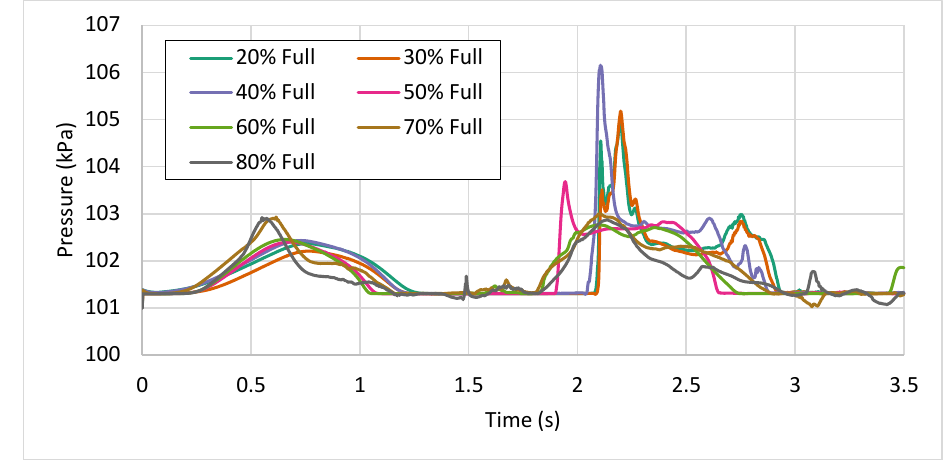
Figure 7. Pressure curves at different fill levels.